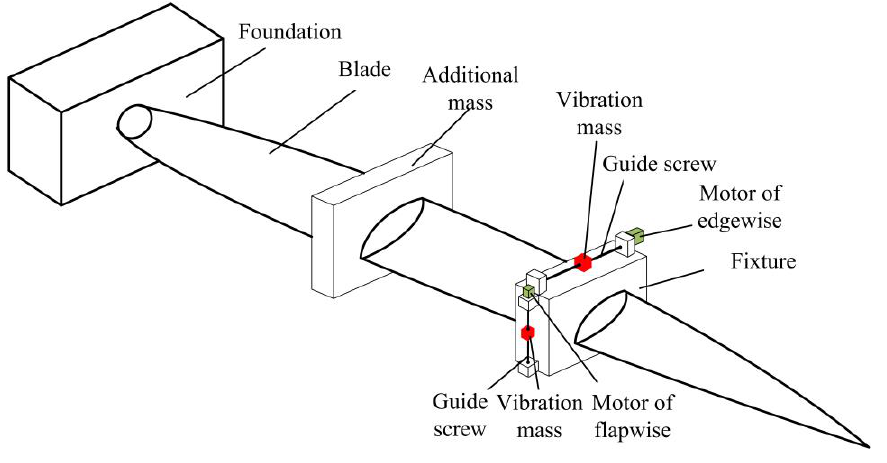
Figure 5. Biaxial resonant fatigue testing